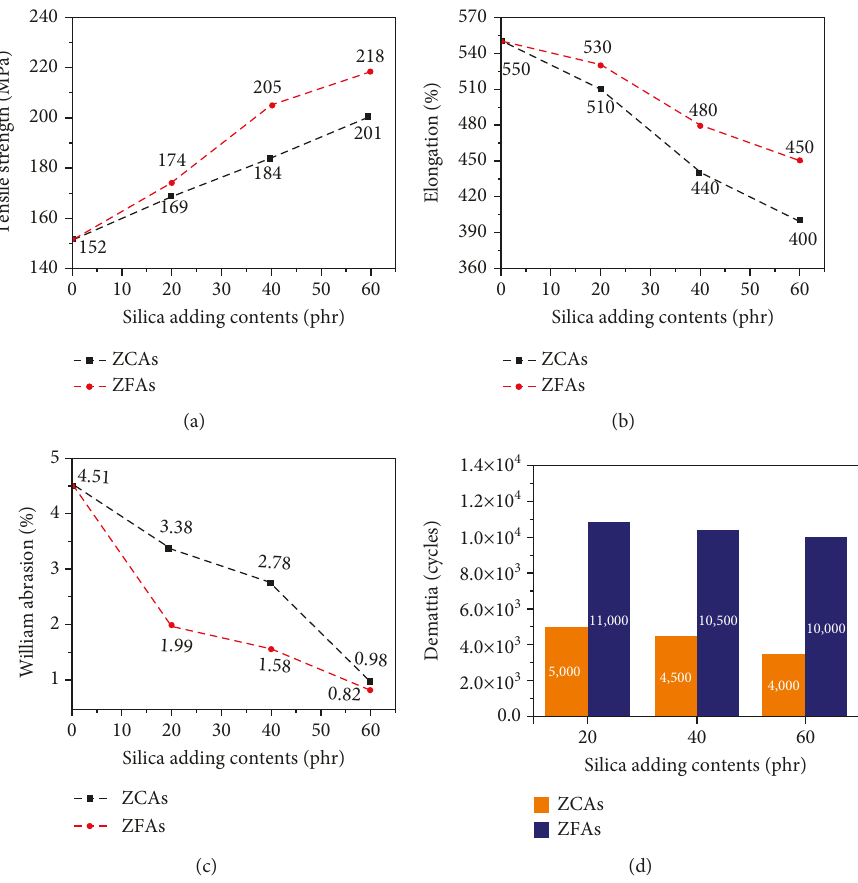
Figure 4: (a) Tensile strength, (b) elongation, (c) William abrasion, and (d) fatigue properties (fatigue crack generation) of rubber composites containing ZCAs or ZFAs with varying degrees of silica